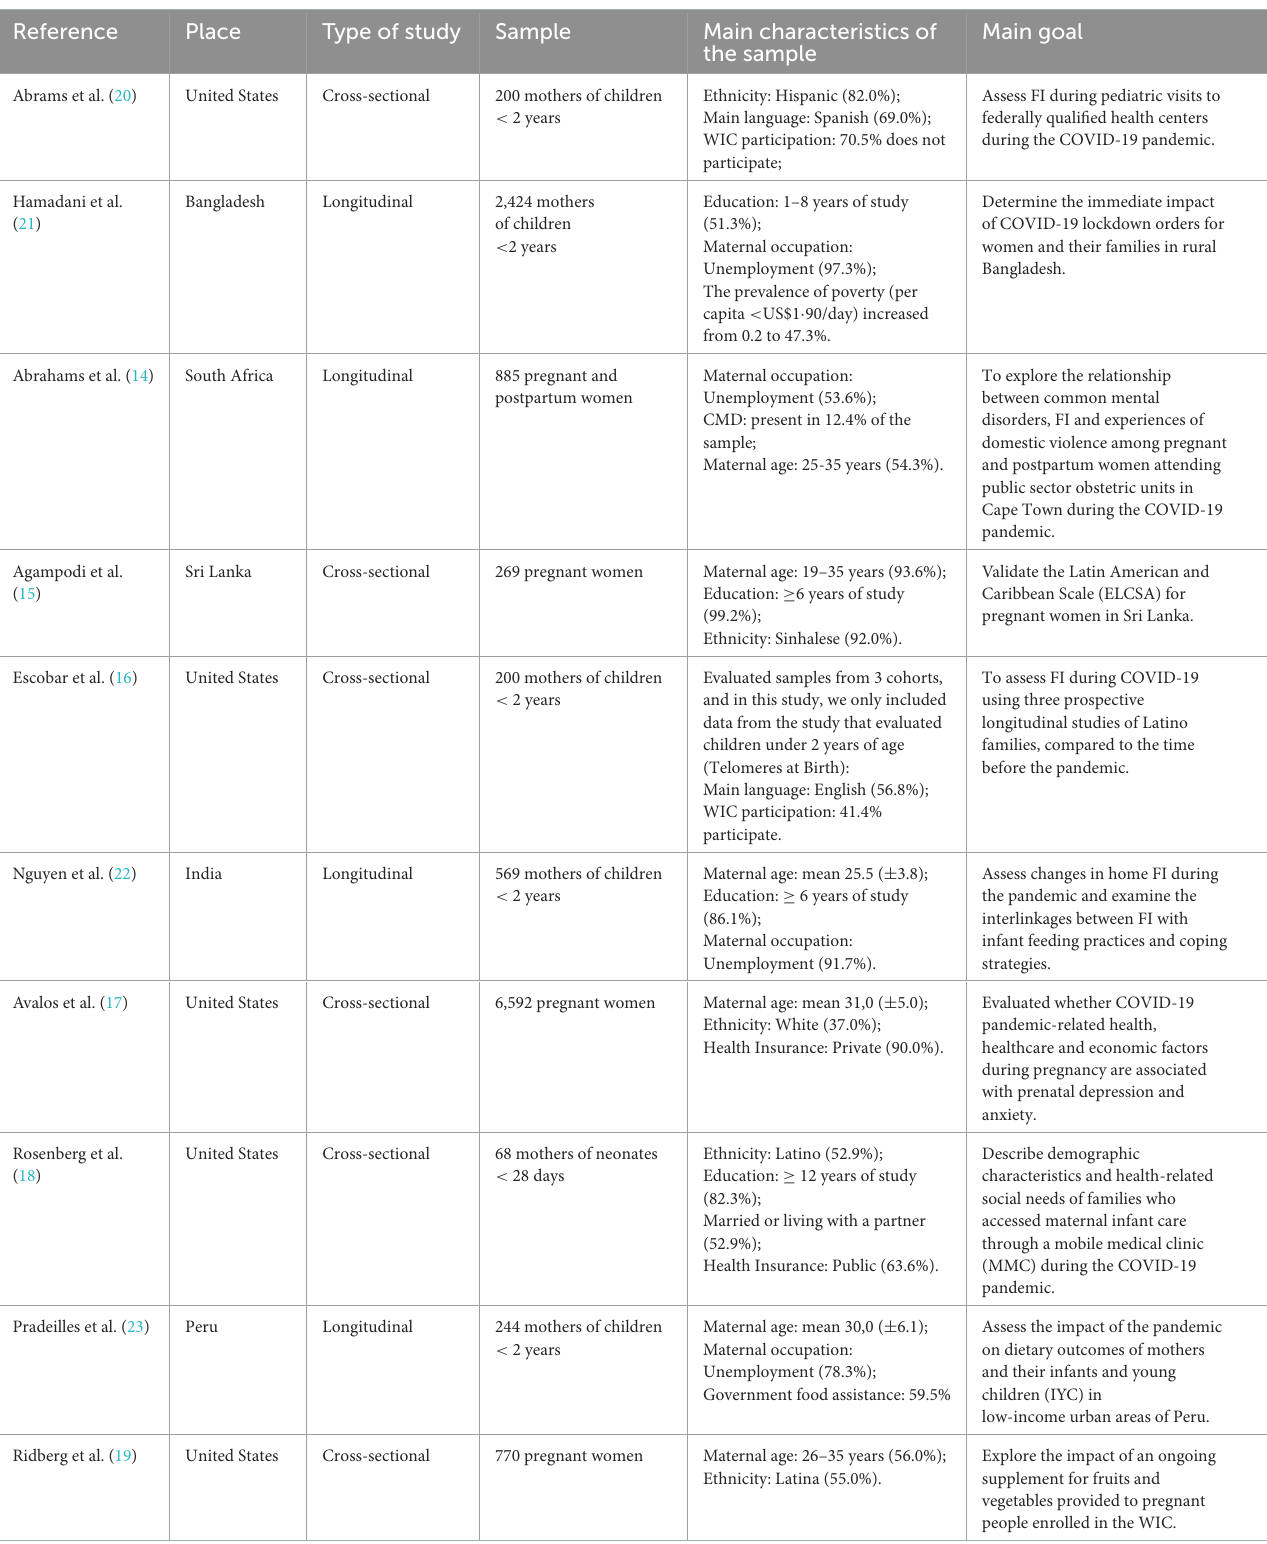
TABLE 1 Description of included studies and sample